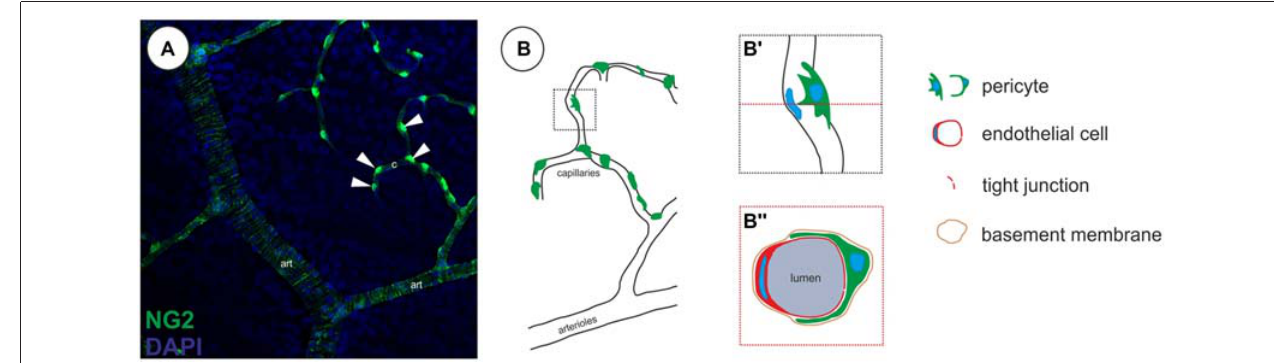
FIGURE 1 | Localization of pericytes within the retinal vasculature. (A) Retinal vasculature, showing a single neural glial antigen 2 (NG2)-positive (green) vSMCs layer on arterioles (art) and single NG2-positive pericytes on capillaries (c, arrowheads; in accordance with results in Trost et al., 2015). (B) Illustration of the localization of pericytes on capillaries. (B (cid:48) ) Pericytes are located abluminal of endothelial cells, (B (cid:48)(cid:48) ) wrapping around the capillary, embedded within the same basement membrane as demonstrated in a capillary cross-section.